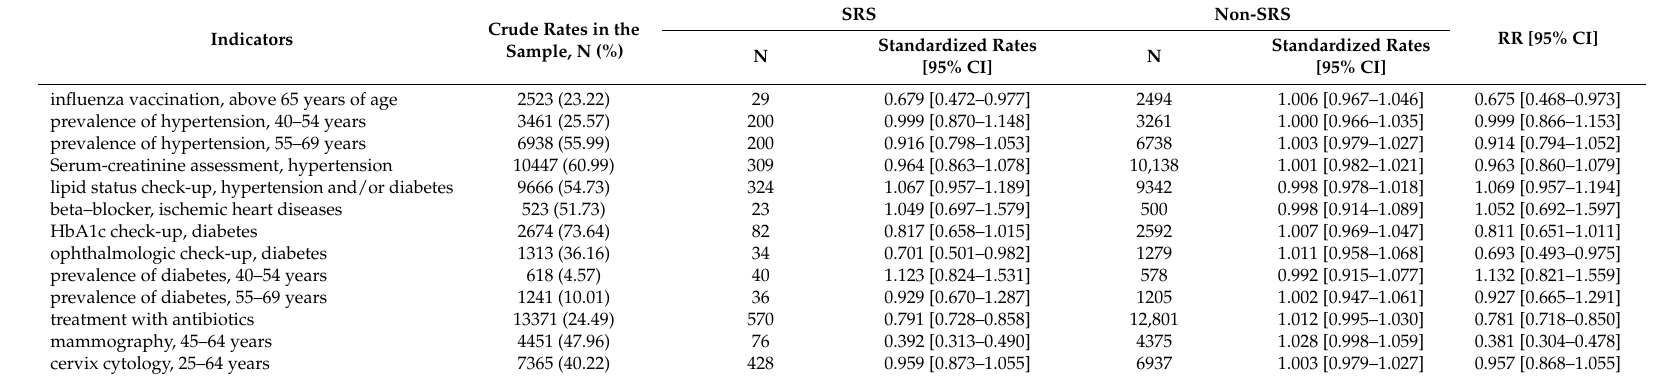
Table 3. Service delivery rates as performance indicators for adults living in segregated Roma settlements (SRSs) and living in the same municipalities’ complementary areas (non-SRSs) with the age- and sex-standardized relative service delivery rates (RRs) for inhabitants of SRSs. SRS Non-SRS RR [95% CI] Indicators Crude Rates in the Standardized Rates Standardized Rates Sample, N (%) N N [95% CI] [95% CI] influenza vaccination, above 65 years of